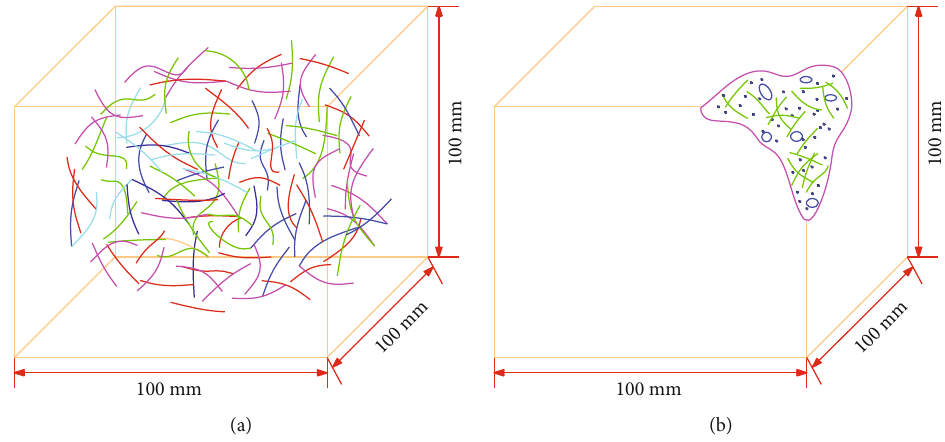
Figure 1: Internal structure of fi ber-reinforced concrete.